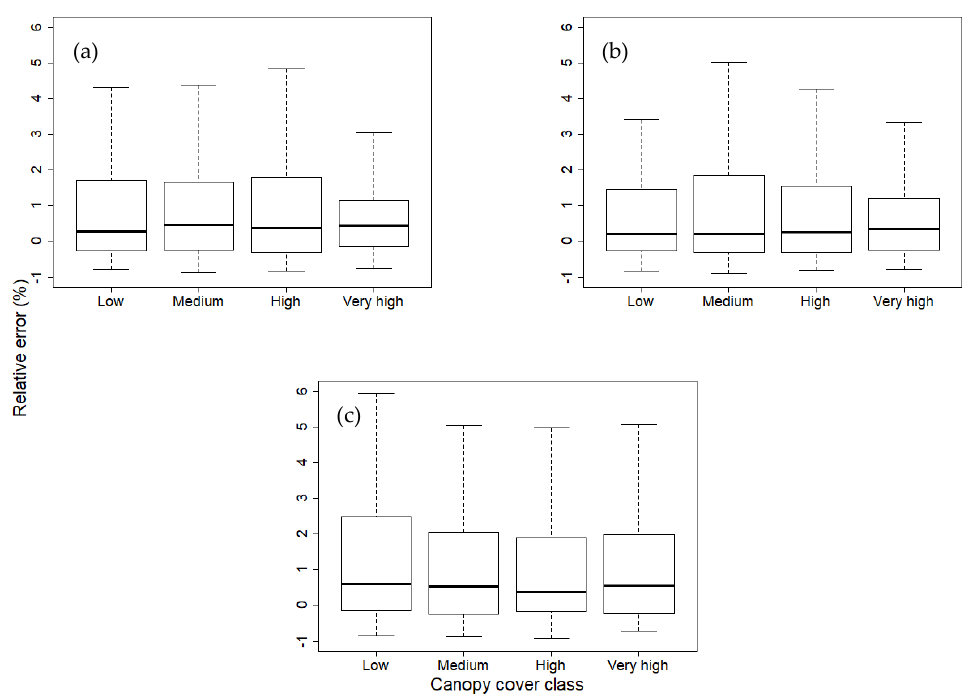
Figure 5. Distribution of the relative error (%; Equation (3)) as a function of canopy cover class (low: 0% to 24%, medium: 25% to 49%, high: 50% to 74%, and very high: ≥ 75%) for models estimating sapling density (stems/ha) of commercial species. ( a ) Model integrating both sensors, ( b ) model including LiDAR and environmental variables, and ( c ) model including spectral and environmental variables (Kruskal–Wallis test, (a) p = 0.85, (b) p = 0.99, and (c) p = 0.72).